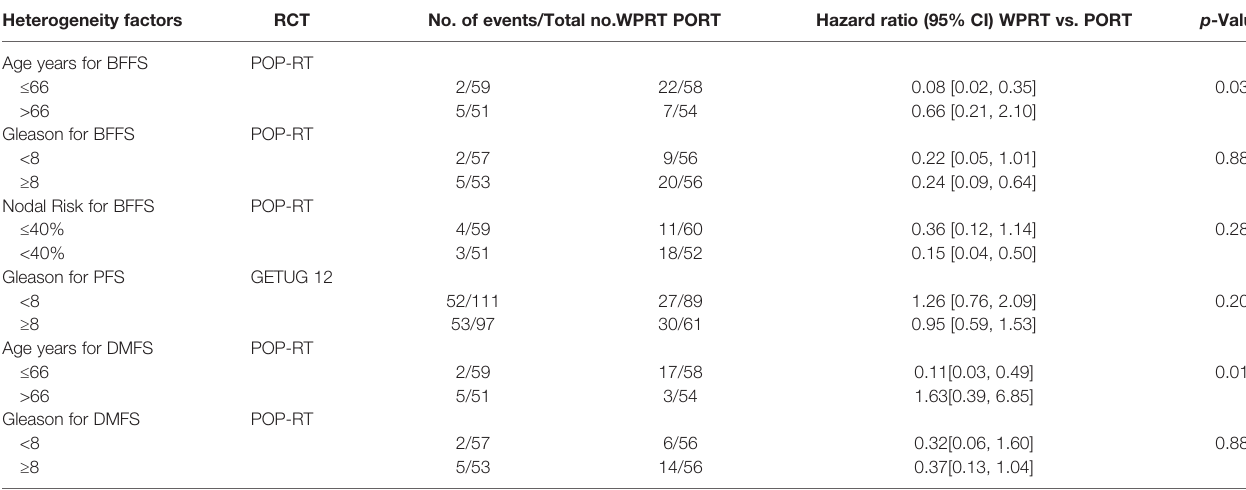
TABLE 3 | The possible dependence between the clinical bene fi t of WPRT and patient characteristics in RCTs. Heterogeneity